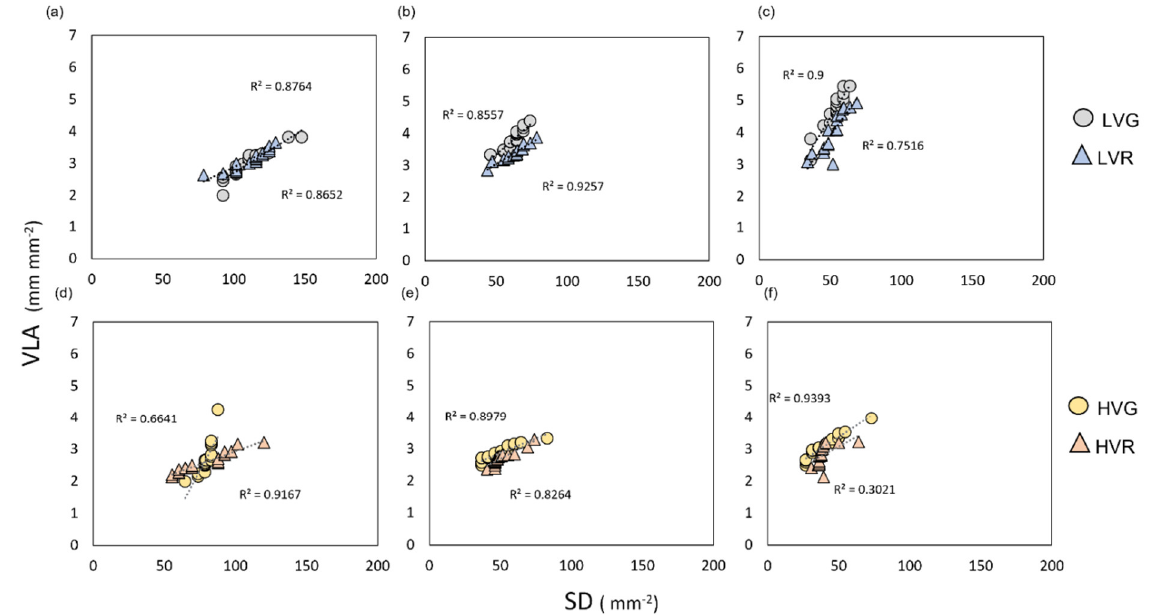
Figure 4. ( a – c ) Vein and stomatal density relationships of grey (circles) and red (triangles) lettuce grown under low VPD in the bottom, LVb ( a ); middle, LVm ( b ); and apex, LVa ( c ) part of the leaf. ( d – f ) Vein and stomatal density relationships of grey (circles) and red (triangles) lettuce grown under high VPD in the bottom, HVb ( d ); middle, HVm ( e ); and apex, HVa ( f ) part of the leaf. Regression lines and R 2 values are also shown.